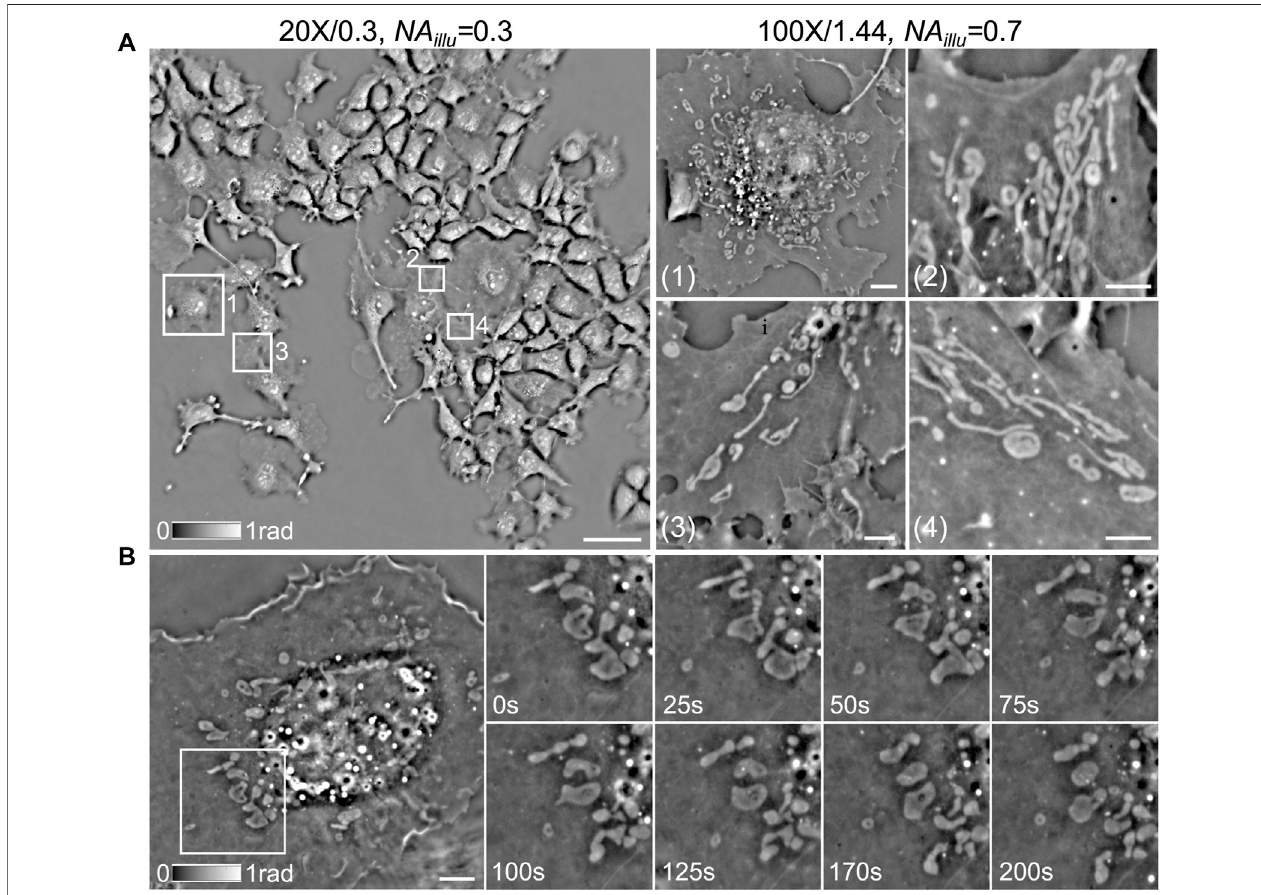
FIGURE 4 | Phase imaging of live Cos7 cells with CF-QPCM under different con fi gurations. (A) left: phase image of live Cos7 cells obtained with the large-FOV imagingmode;right:phaseimagesofseveralsub-regionsmarkedwithwhiteboxesontheleft,obtainedwiththesmall-FOVimagingmode. (B) left:phaseimageofalive Cos7 cell obtained with the small-FOV imaging mode; right: time series of mitochondrial fi ssion in the white box on the left. Scale bars in (A) -left, (A) -right, and (B) are 65 μ m, 4 μ m, and 6 μ m, respectively.